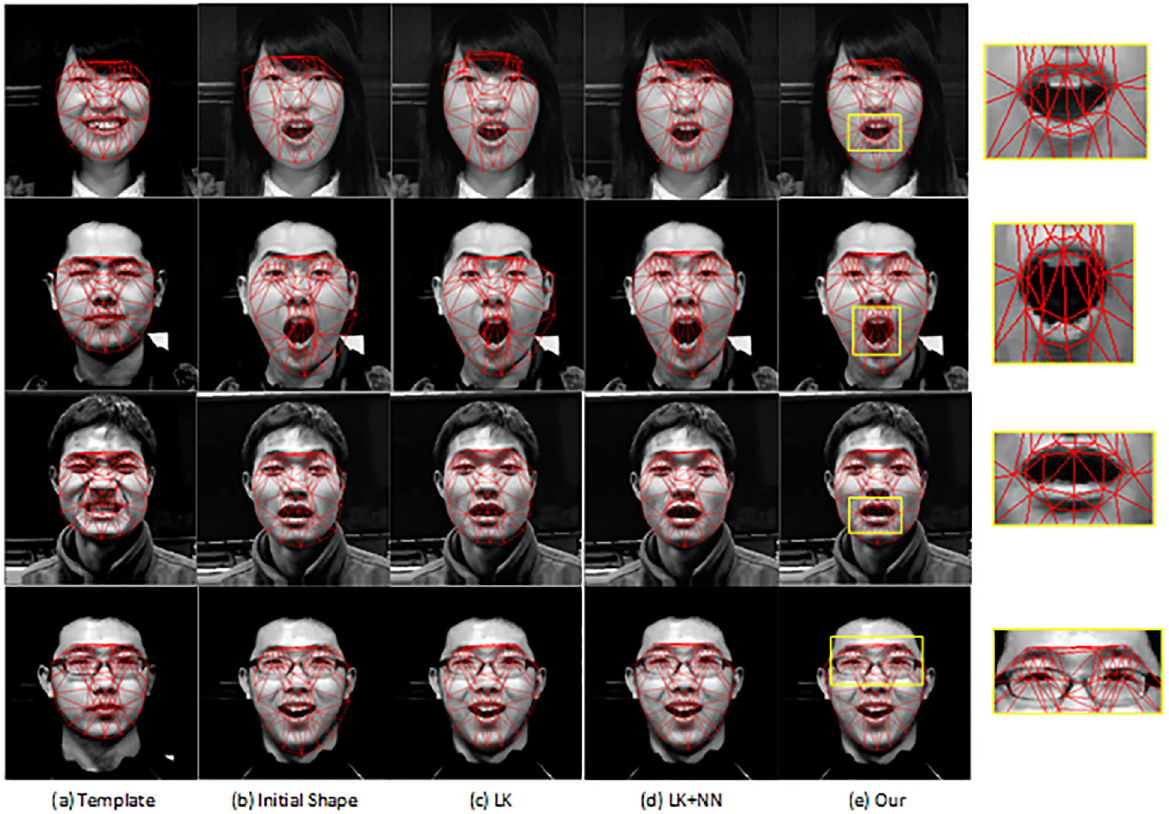
Fig 3. Comparison of the face alignment using LK, LK+NN and our methods on real images. (a) Template with annotated landmarks. (b) Target image with initial shape parameter. (c) The results of Lucas-Kanade method. (d) The results of LK method with the nearest neighbor search. (e) The results of our method, which is Lucas-Kanade method with KPP search ( K =